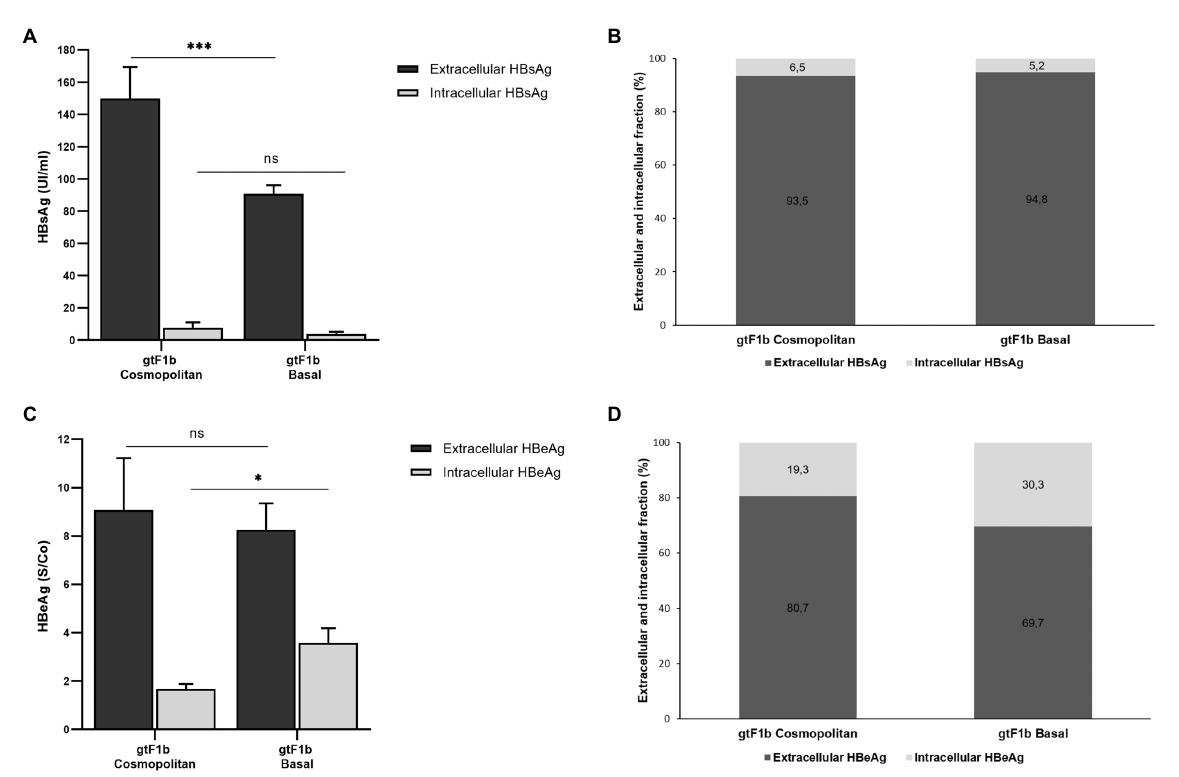
FIGURE 4 Analysis of intracellular and secreted HBsAg and HBeAg levels of gtF1b Cosmopolitan and gtF1b Basal variants. HuH-7 cells were transfected with linear full-length HBV genomes of gtF1b Cosmopolitan and gtF1b Basal variants. Three days’ post-transfection, cells and culture supernatants were harvested. Intracellular and extracellular levels of HBsAg and HBeAg were determined by ECLIA (A,C) . Extracellular/intracellular HBsAg and HBeAg ratio (B,D) . Values shown represent the mean ± standard deviation of three independent experiments. *** p < 0.0001; * p < 0.05; ns: no statistical